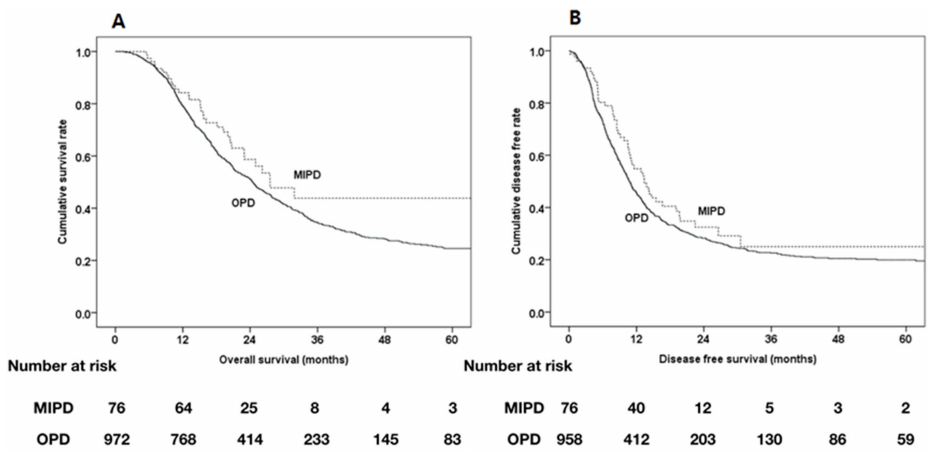
Figure 3. Kaplan-Meier survival curves of MIPD group ( n = 76) and OPD group ( n = 972). (A) The median OS was 27.6 months, and estimated 1-, 2-, 5- year OS were 84.2%, 58.7%, and 43.8%, respectively in the MIPD group, and 24.5 months and 79.3%, 51.2%, and 24.6% respectively, in the OPD group. Log rank p -value for this result was 0.079. (B) The median DFS was 13.4 months, and estimated 1-, 2-,5- year DFS were 54.8%, 32.5%, and 25.0%, respectively in the MIPD group, and 10.7 months and 45.6%, 28.3%, and 19.9%, respectively in the OPD group. Log rank p -value for this result was 0.151. Table 4. Demographics of MIPD and OPD after propensity score